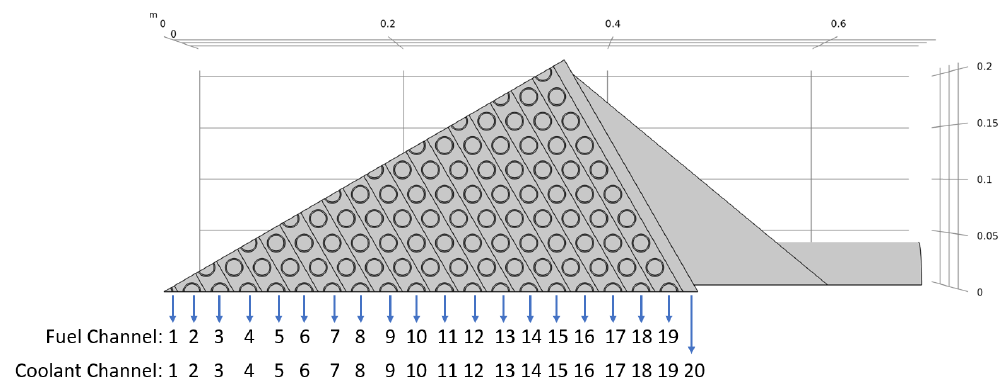
Figure 8. The channel indices of molten salt (fuel) and liquid lead (coolant) at the outlet plane.